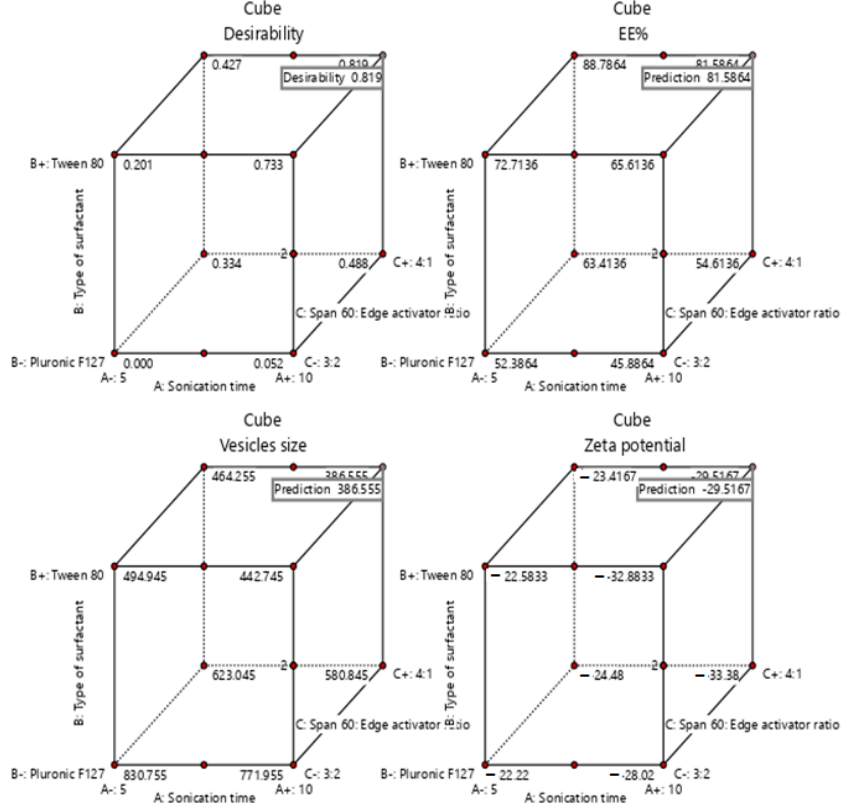
Figure 4. Cube graph for the predicted responses of the optimized formula and desirability.